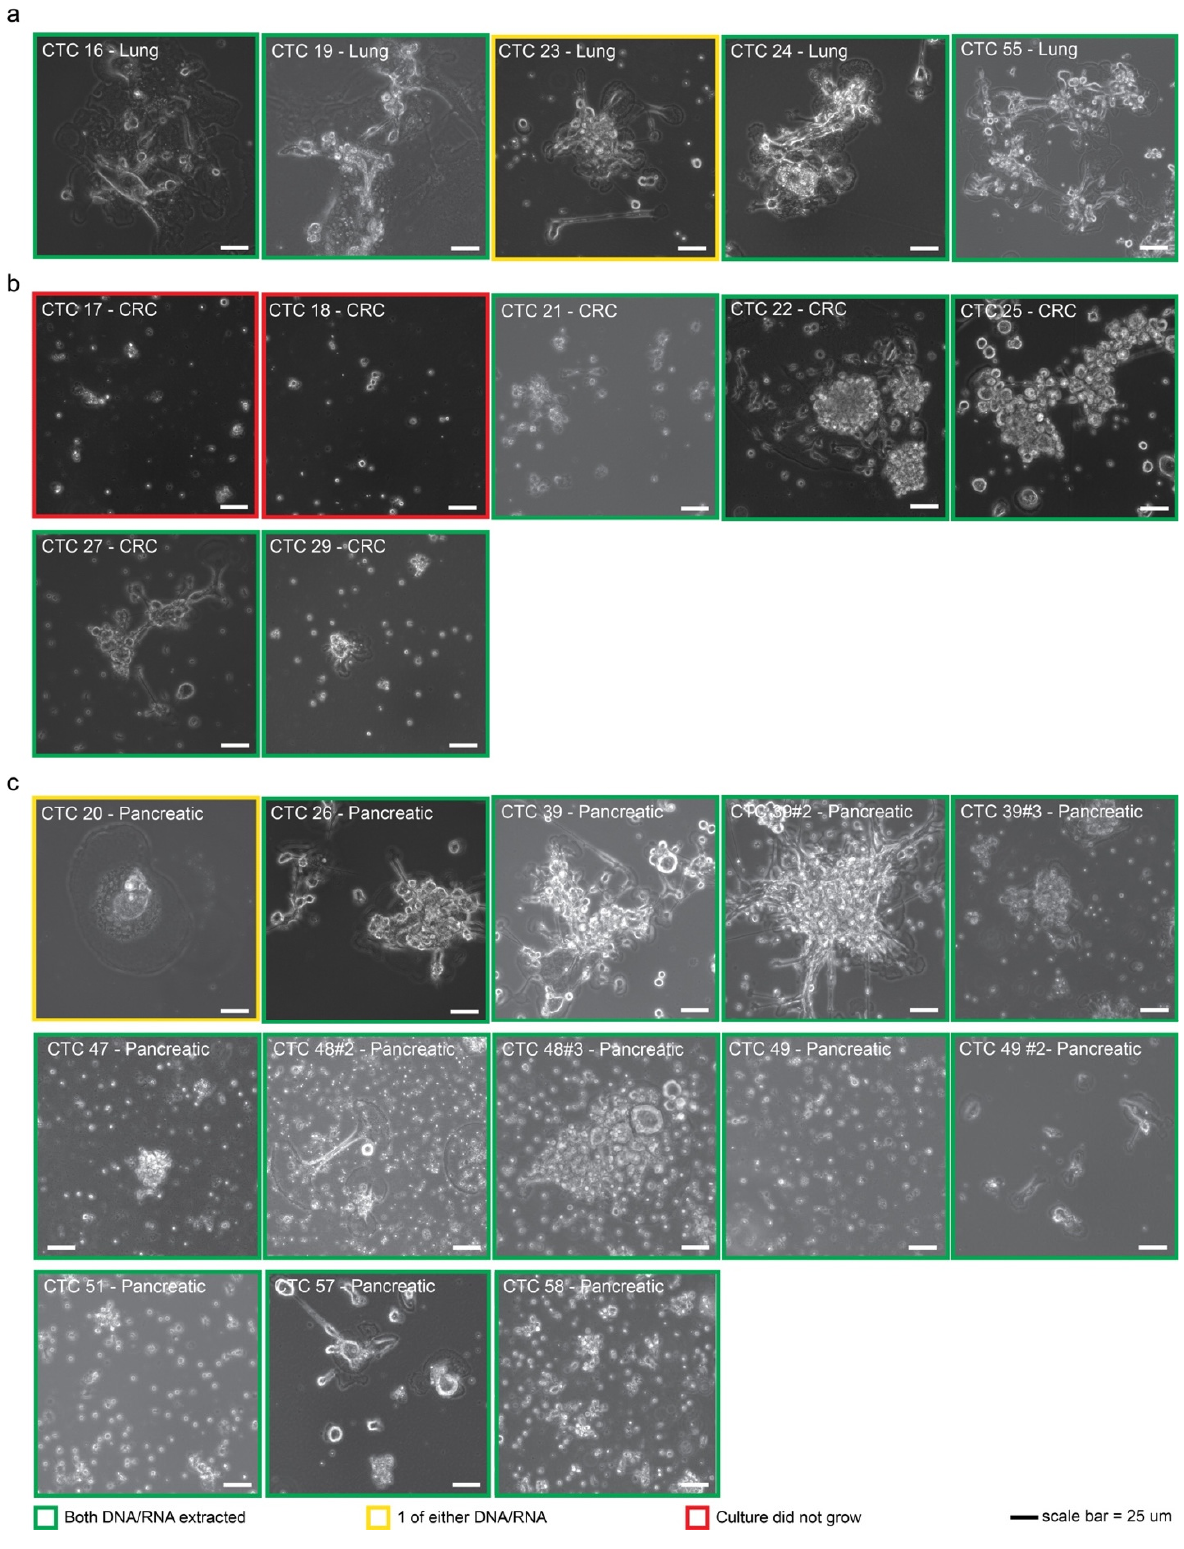
Figure 1 . CTCs derived from multiple cancer types can be cultured. Representative phase images of CTC cultures derived from ( a ) lung, ( b ) colon (CRC), and ( c ) pancreatic metastatic tumors are shown. Images are outlined based on the ability to gather high-quality RNA or genomic DNA. Scale bar = 25 um.